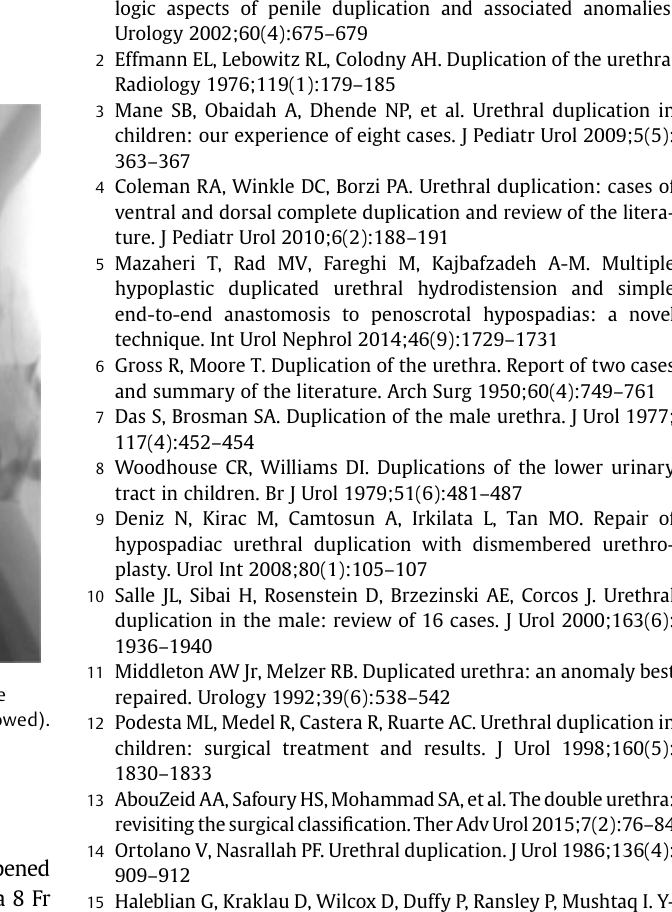
urine fl ow is high. 10 Therefore in the case described, we opened the dorsal urethra and performed a tubularization over a 8 Fr catheter, as in the classic repair for hypospadias.